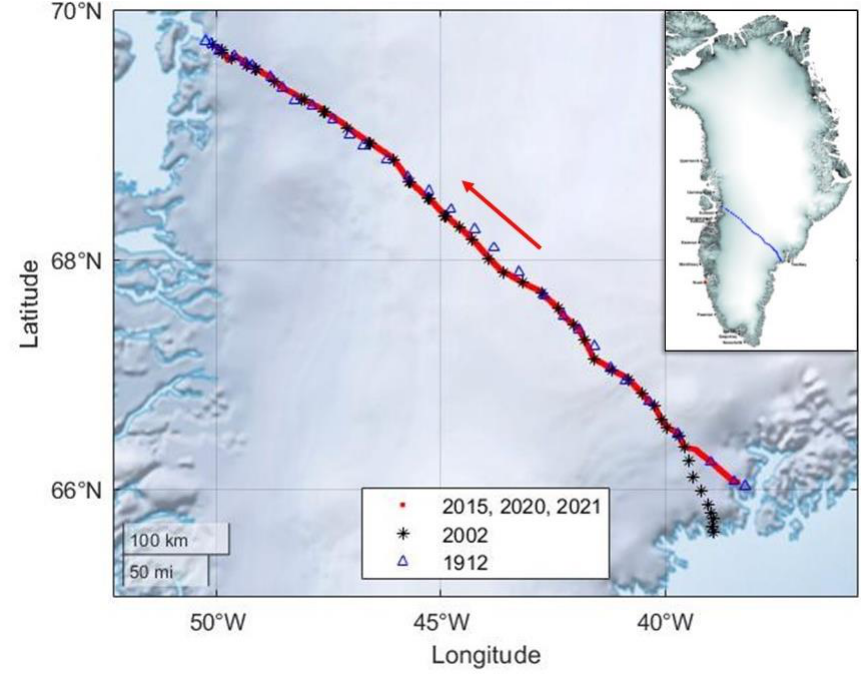
Figure 2. Map of Greenland [17] and route of Greenland Korth Expedition (GKE) with walking direction, camps from 2002 and historical camps from 1912. The blue line approximately marks the catchment area of the Helheim and Ilulissat (Jakobshavn) glaciers and the top of the Greenland ice sheet.